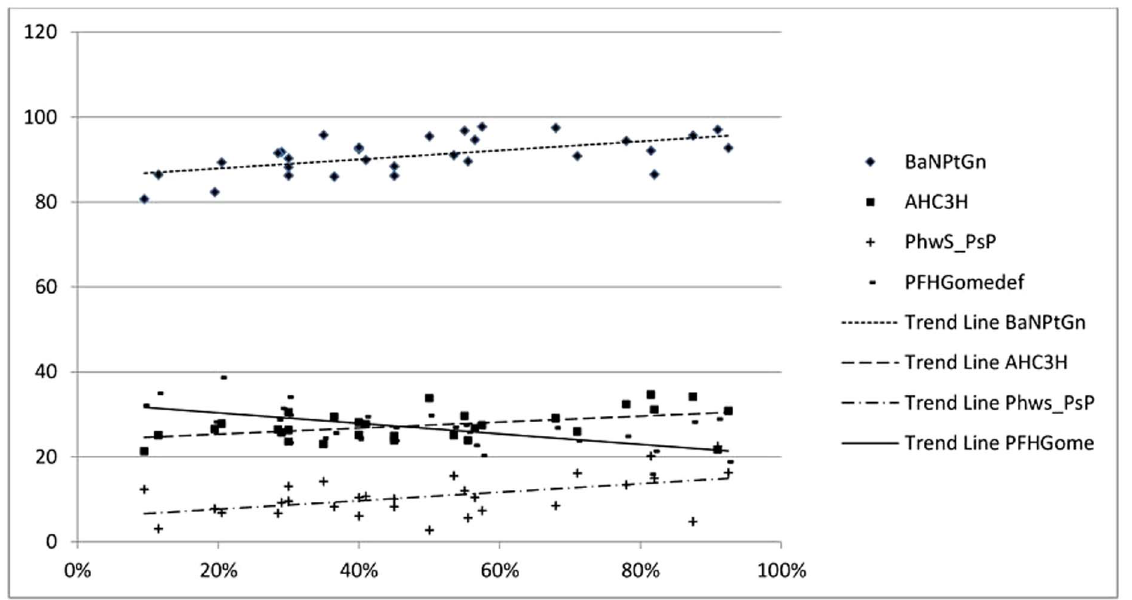
Figure 3. Correlations between nasal patency as fraction of predicted values of nasal flows, BaN ‘ PtGn, the upper angle measured between total cranic base (BaN) and facial axis (Pt Gn) (r 0.570; p , 0.001) and AH-C3 H, the horizontal distance from AH to C3 (r 0.46; p=0.009).